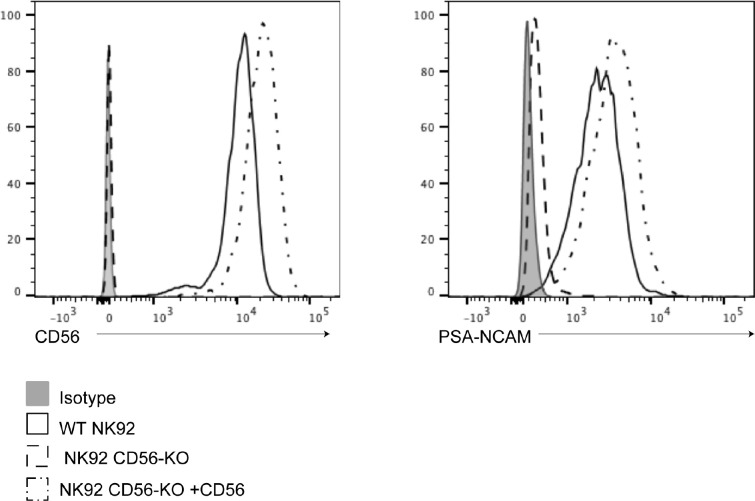
Re-expression of CD56 and PSA-NCAM in reconstituted NK92 cell lines.CD56 (left) or PSA-NCAM (right) were detected by flow cytometry on WT (solid line), CD56-KO (dashed line) or CD56-KO cells reconstituted with NCAM140 (dot-dashed line). Isotype antibody was used as a negative control (solid filled histogram). Shown is one representative of two independent repeats.